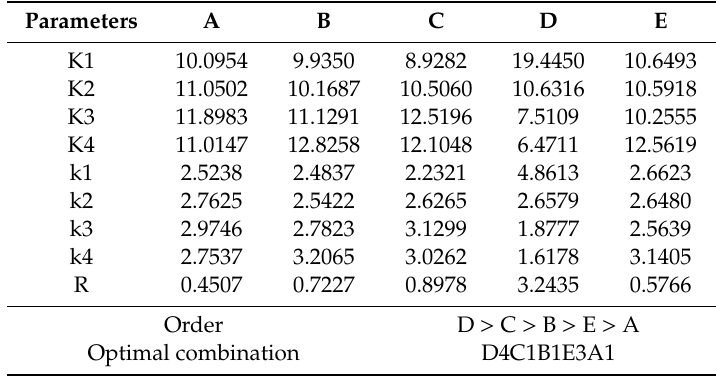
Table 4. Analysis of the results using range method for the uniformity of external mixing